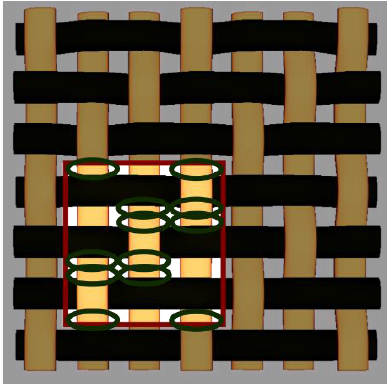
Figure 6. The RUC of satin 3/1/1 relative to a 7 × 7 yarns reference area. The resulted undulation density ( ρ 3/1/1 ) is this time only 66%, as given by the Equation (4).